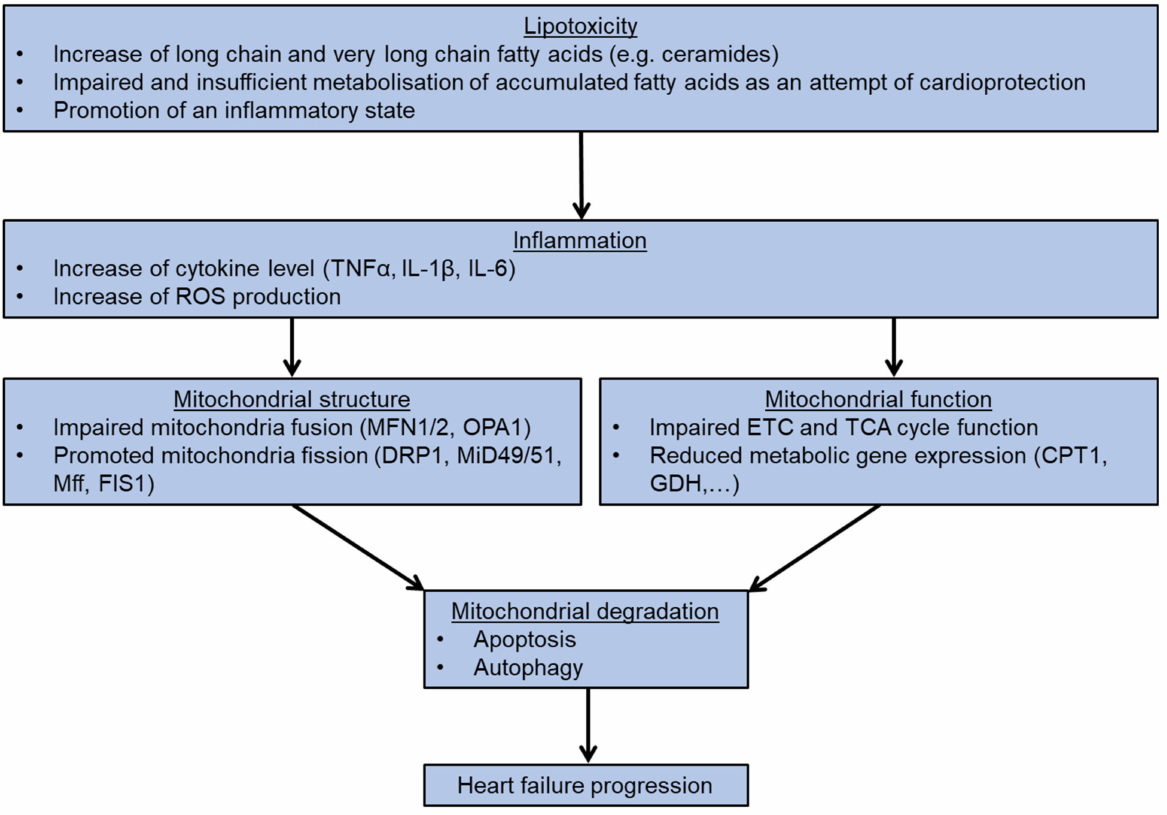
Figure 4. Flowchart presents the process of heart failure development following